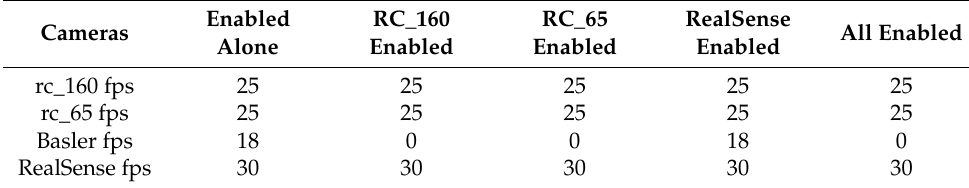
Table 4. Frames per second (FPS) of active cameras.